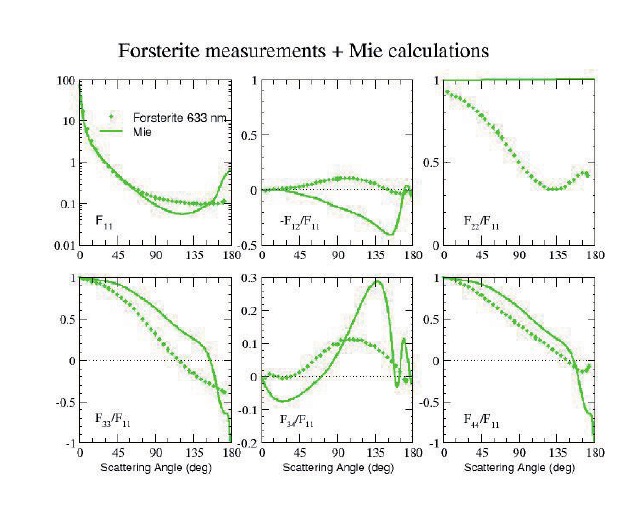
Fig. 3 Measured scattering matrix elements as functions of the scattering angle of olivine S (forsterite) at